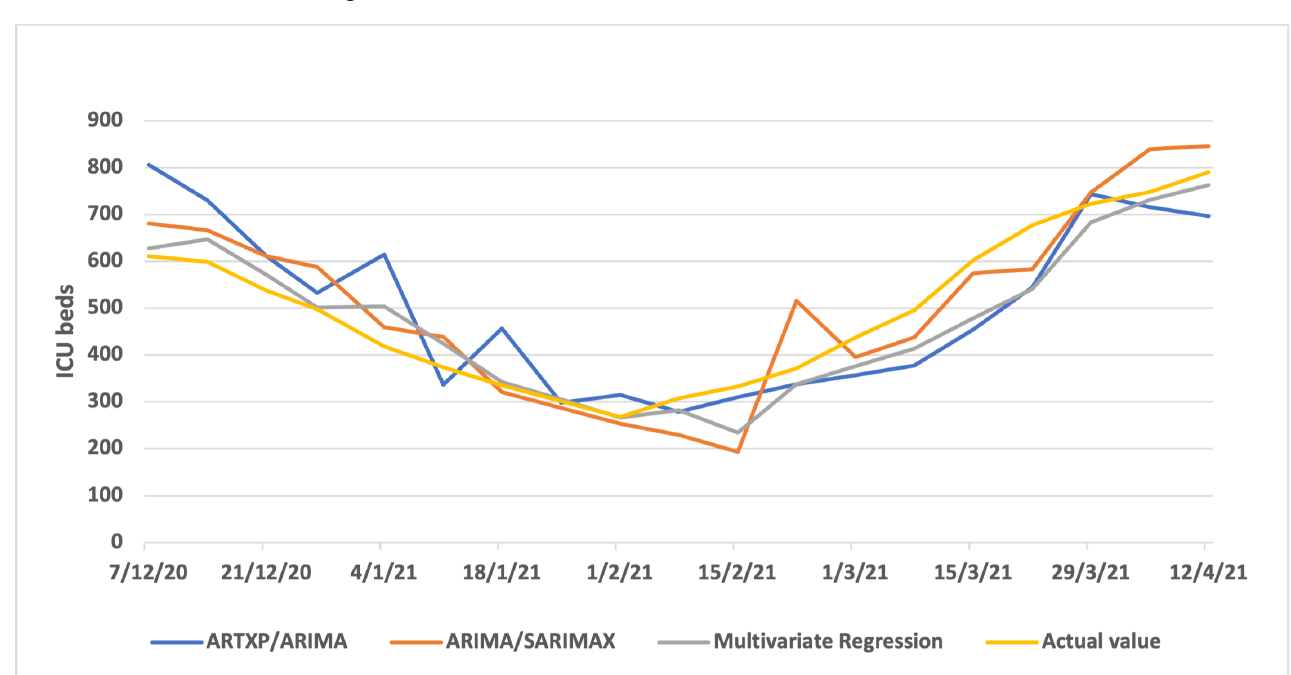
Figure A7. One week Predicted vs. Actual ICUs—Greece.